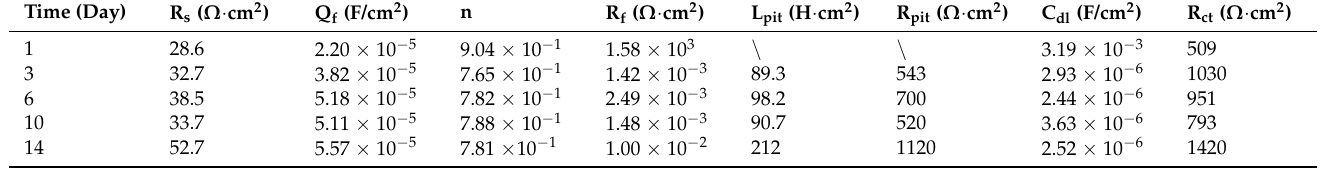
Figure 8. Nyquist plots of AZ31B magnesium alloy in different corrosion conditions recorded at different times. ( A ) abiotic mud, ( B ) biotic mud.